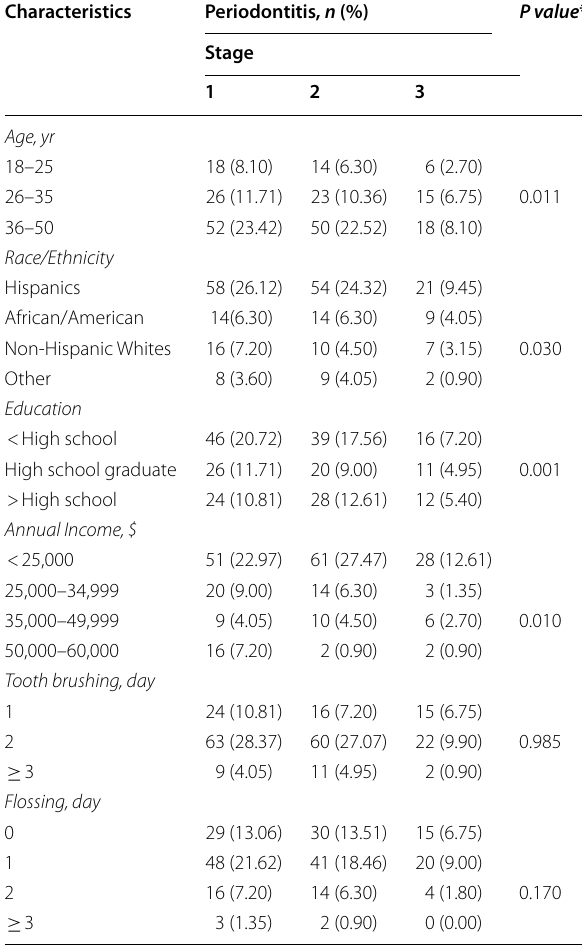
Table 1 Demographic characteristics of low‑income